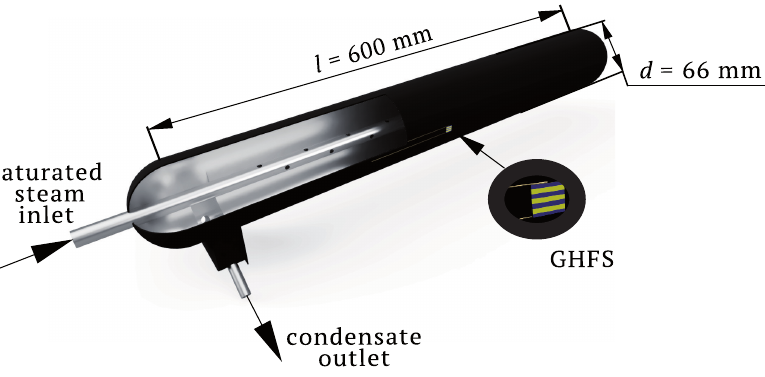
Figure 1. Cylinder structure.